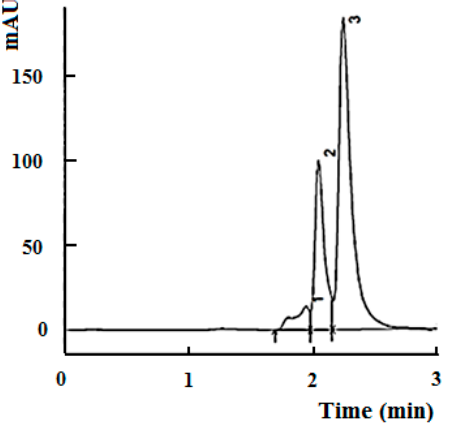
Figure 13. Chromatograph of solution after 45 min hydrogel immersion in saline solution, peaks: hydrochloride chitosan (1), apple pectin (2), cisplatin (3).